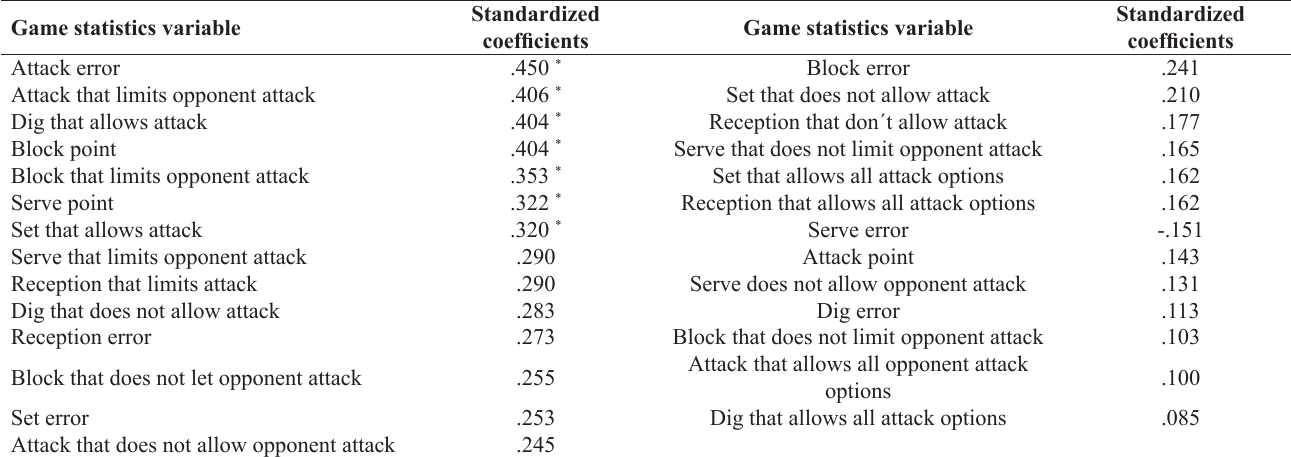
Table 6. Standardized coefficients from the discriminant analysis done in the sixth stage (ability of the instrument to predict winning and losing women´s teams in the 2008 Olympics Games).